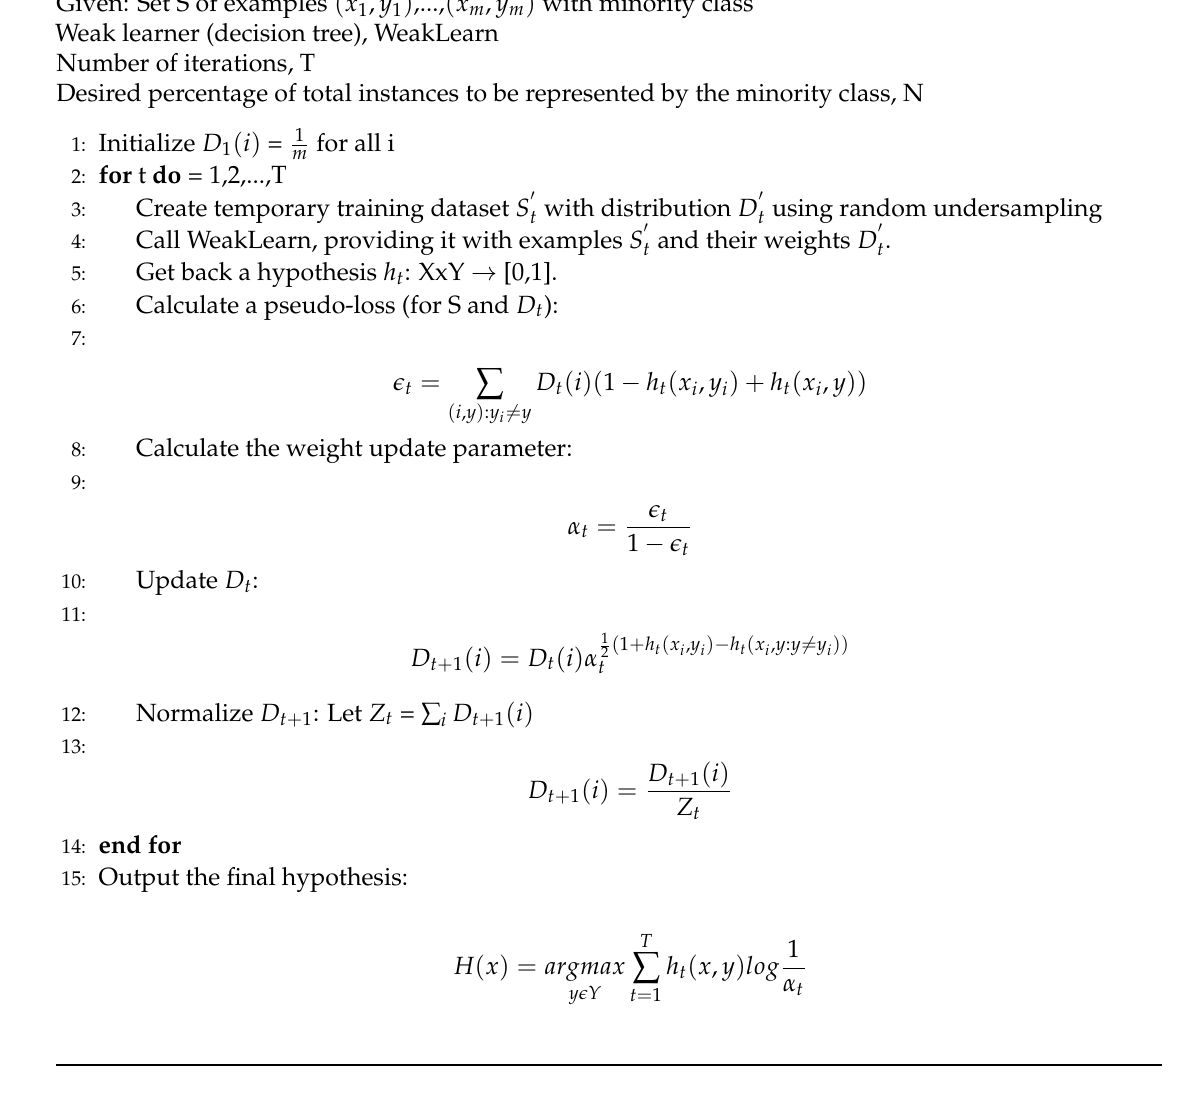
Algorithm A1 RUSBoost Algorithm(Adapted from [65]). Weak learner (decision tree),